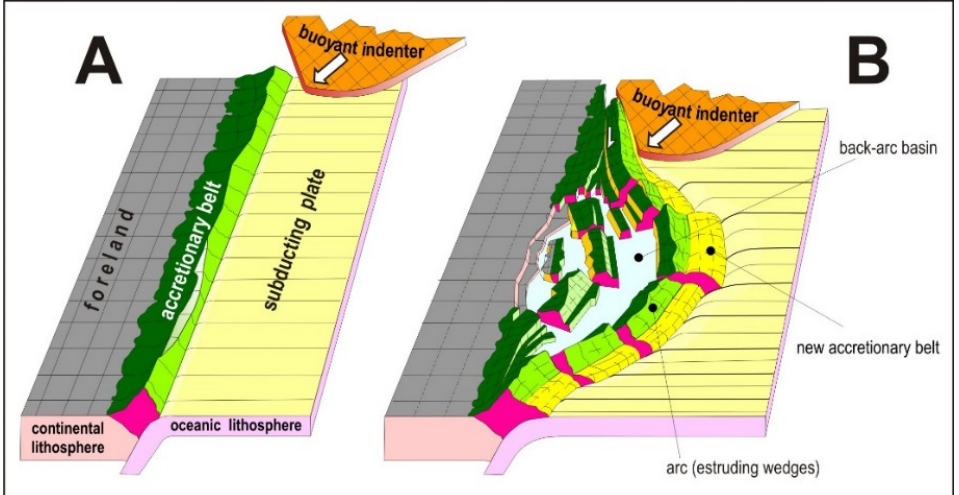
Figure 2. Sketch of the tectonic process that is supposed to generate TABA systems. ( A ) An orogenic belt, flanked by an oceanic domain, is longitudinally stressed by a continental indenter. ( B ) The stressed structure detaches from the foreland and undergoes uplift and oroclinal bending, through the lateral escape of crustal wedges. The extruded orogenic material overthrusts the oceanic domain inducing its downward flexure and consequent sinking. The separation of the migrating and bowing Arc from the overriding plate induces crustal extension in the interposed zone (Back Arc basin), whereas accretionary activity occurs at the front of the extruding Arc. See [33,34] for laboratory modeling of that process.